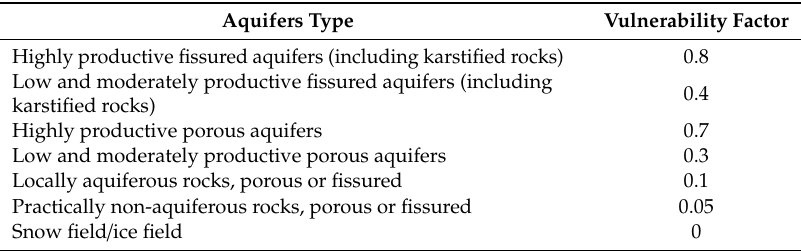
Table 5. Aquifers productivity in Grand Est region.